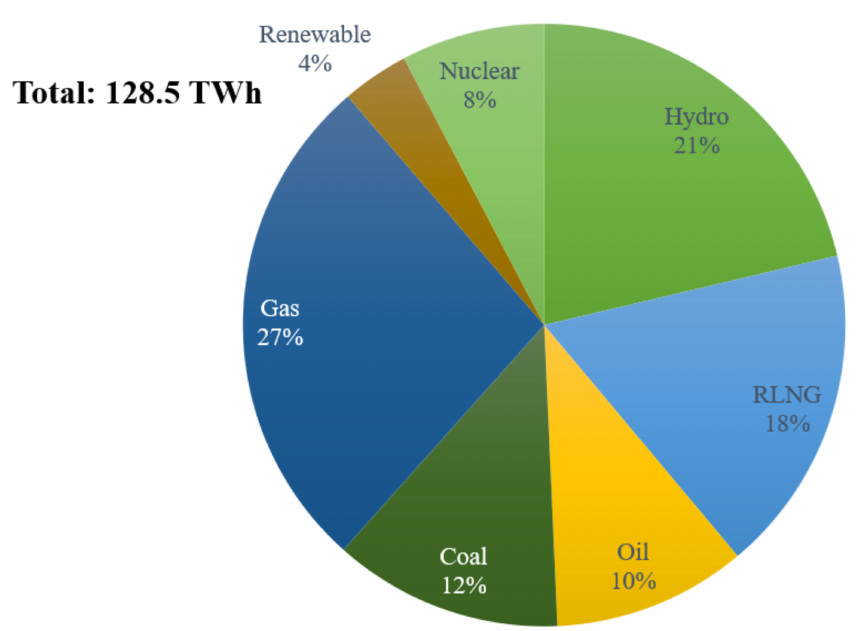
Figure 4. Primary energy consumption by sector [7].